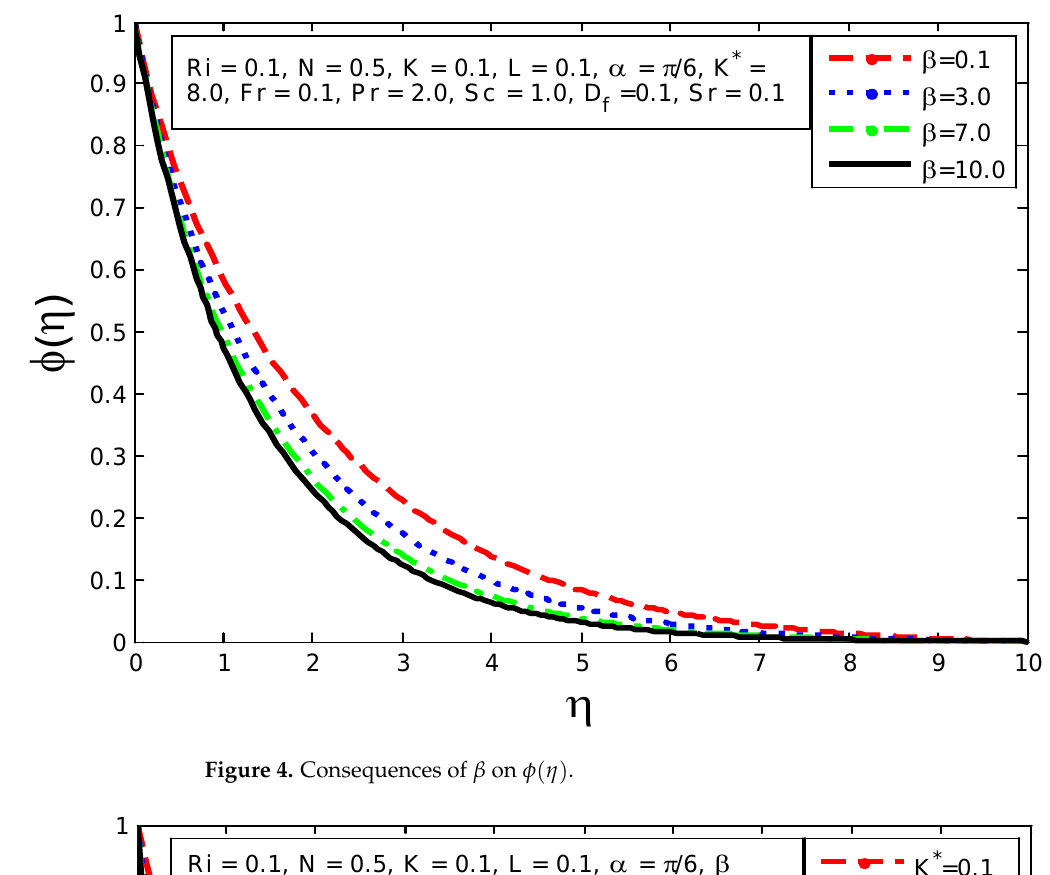
Figure 4. Consequences of β on φ ( η ) .